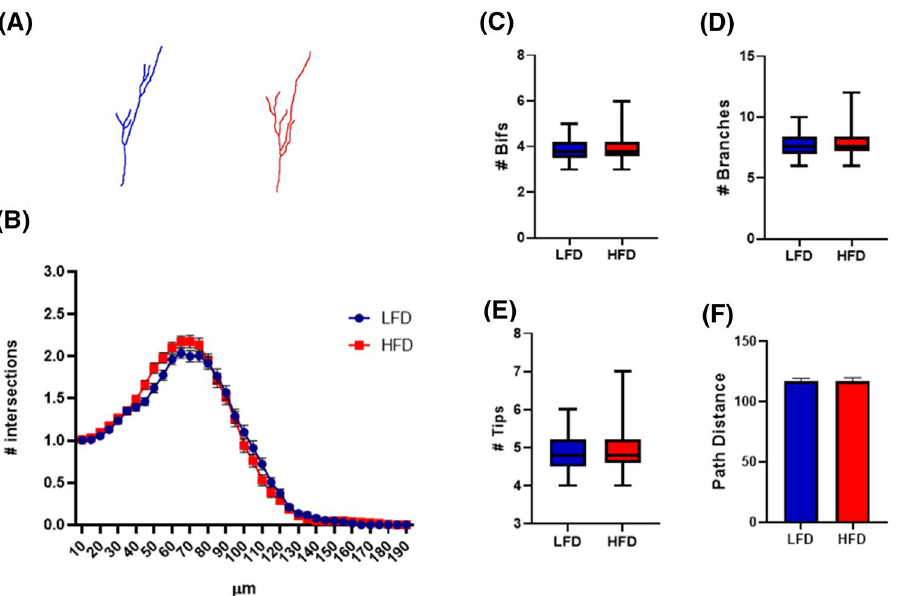
Figure 5. No effect of 7-day HFD on cellular complexity of DCX + cells in the ventral hippocampus. Representative DCX + cell 3D morphological reconstruction in the ventral hippocampus of animals fed with a LFD (Blue) or HFD (Red) for 1 week ( A ). Sholl intersections profiles of DCX immunolabeled cells of the dentate gyrus of the ventral hippocampus of animals fed for 7 days with HFD (Red) or LFD (Blue) starting from the fifth week of age (n = 4 animals per group) ( B ). Data are presented as mean ± SEM. Summary of morphometric parameters illustrating the total number of bifurcations ( C ), the total number of branches ( D ), the total number of terminal tips ( E ) and the maximum reached extension from soma ( F ) of DCX immunolabeled cells of the dentate gyrus of the ventral hippocampus of animals fed for 7 days with HFD (Red) or LFD (Blue) starting from the fifth week of age (n = 4 animals per group). Data are represented as Box and Wiskers graph ( C – E ) or bar graph (mean ± SEM) ( F ). ImageJ FIJI software (version 1.52) (https:// imagej. nih. gov/ ij/) was used to produce cell 3D morphological reconstruction. GraphPad Prism 8 (https:// www. graph pad. com/) and Power Point were used to generate the